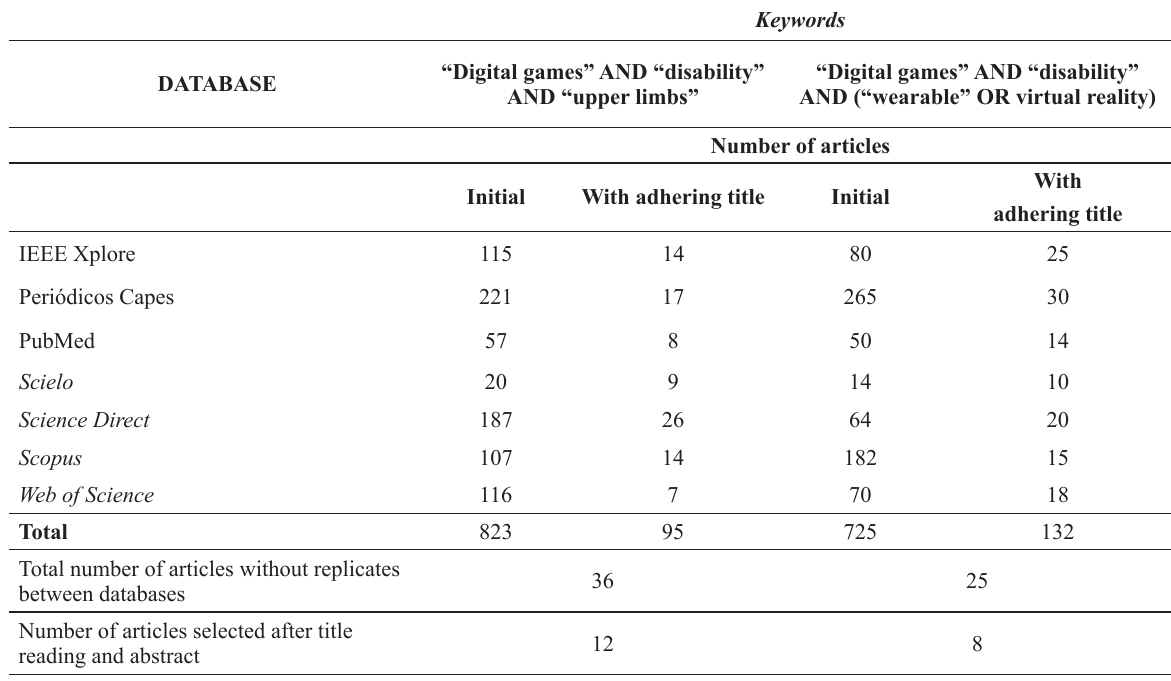
Results obtained in the searches in the databases.